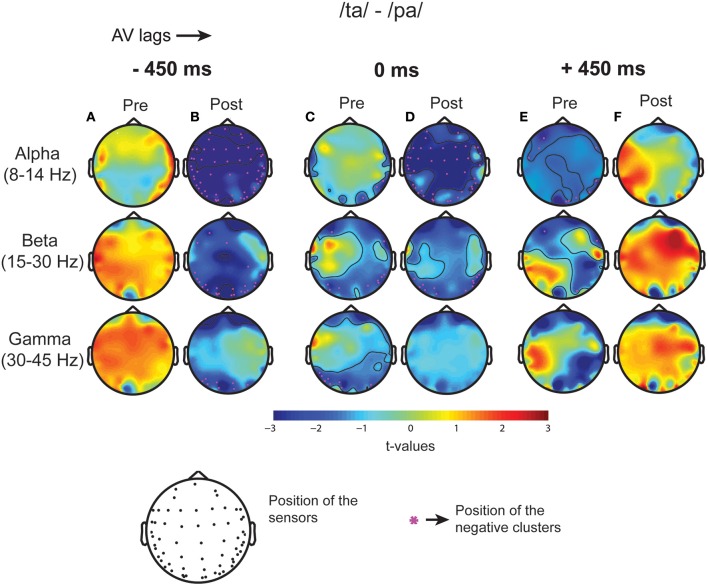
Spectral Difference. The topoplots and the magenta “*” highlight the clusters that show significant difference between the perceptual categories /ta/-/pa/ during the three stimulus conditions: −450 ms AV lag at (A) pre-stimulus onset (B) post-stimulus onset, 0 ms AV lag (C) pre-stimulus onset (D) post-stimulus onset, +450 ms AV lag (E) pre-stimulus onset (F) post-stimulus onset.